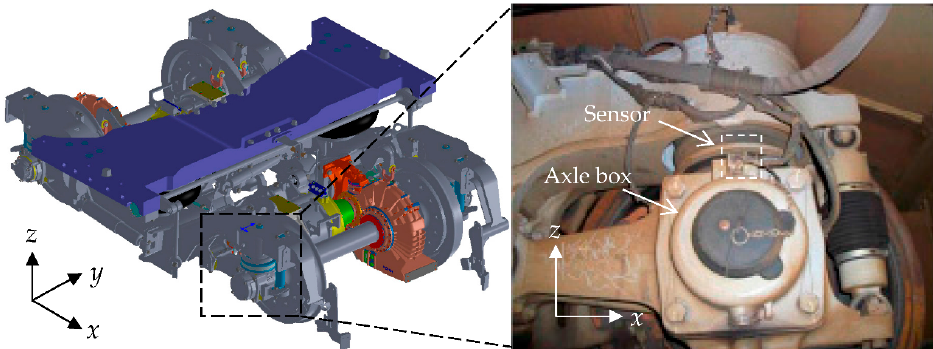
Figure 3. A typical bogie and axle box acceleration (ABA) measurement on an axle box.